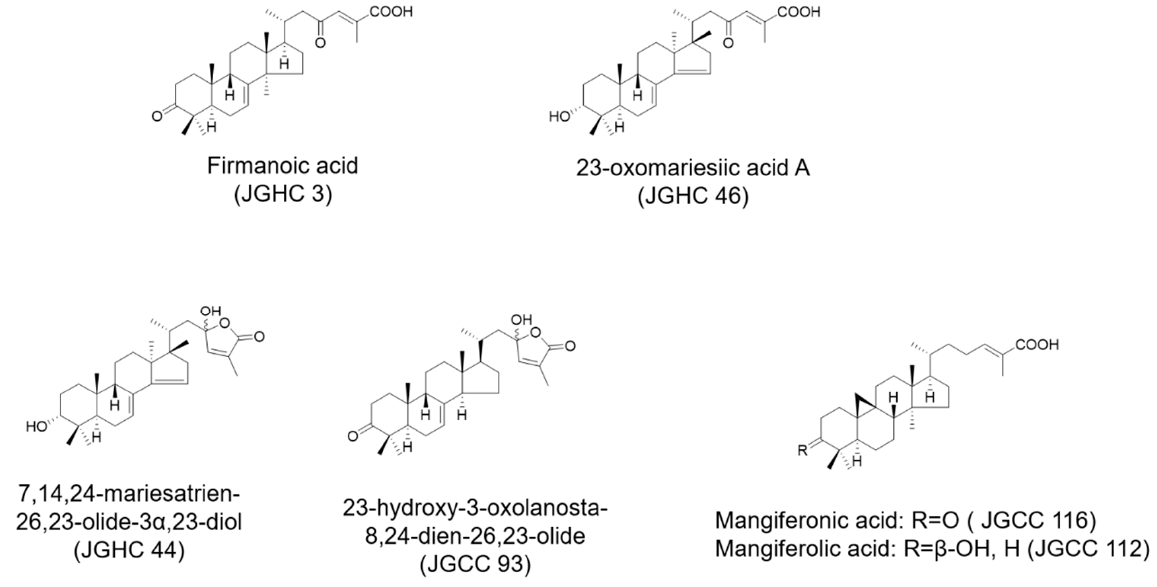
Figure 8. Structures of terpenoids isolated from chloroform- and hexane-soluble fractions of A. hollophylla .